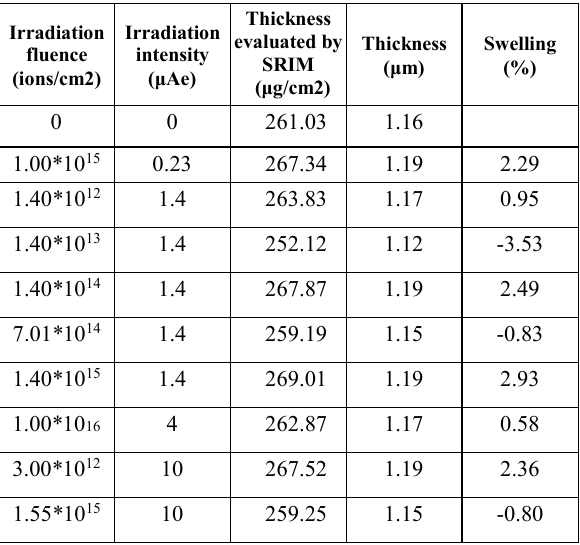
Table 2. Analysis of the measurements of 100 layers HBC